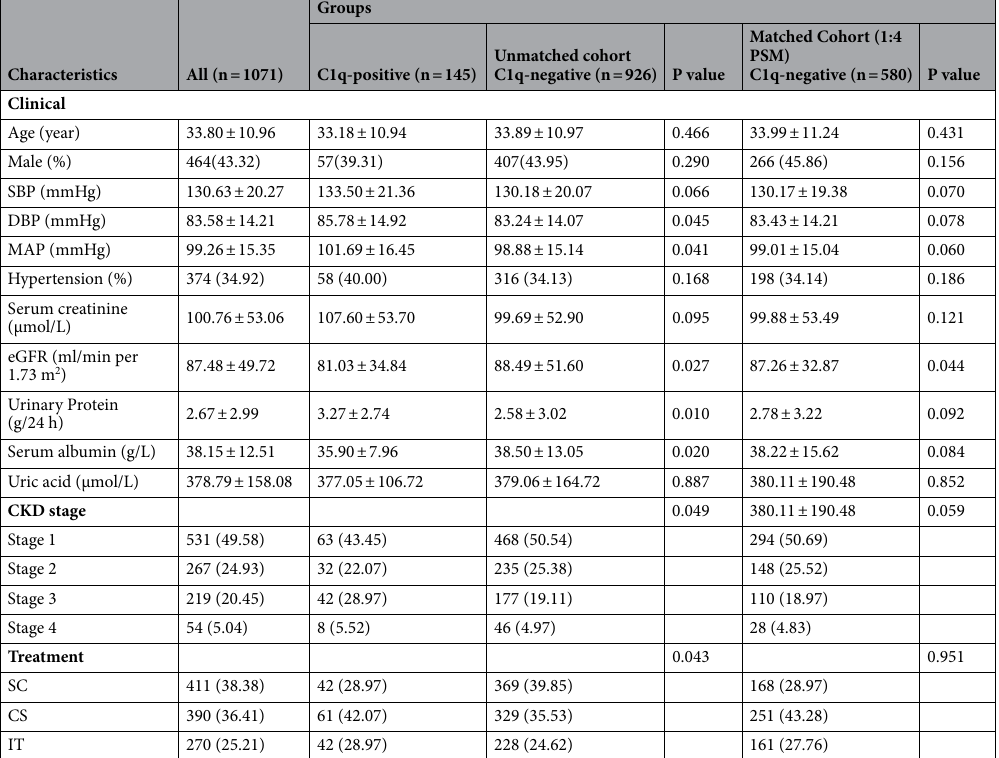
Table 1. Demographic and clinical features of IgAN patients. Values for categorical variables are given as number (percentage); values for continuous variables are given as mean ± standard deviation or median (interquartile range). SBP systolic blood pressure, DBP diastolic blood pressure, MAP mean arterial pressure, eGFR estimated glomerular filtration rate, CKD chronic kidney disease, SC supportive care group, CS corticosteroids, IT immunosuppressive